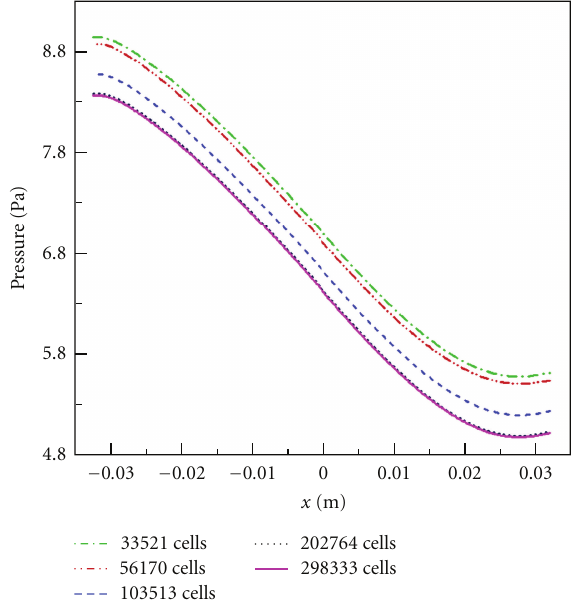
Figure 5: Profiles of static pressure calculated using five meshes. Plotted along y = 0, in the range of − 0 . 32 ≤ x ≤ 0 .